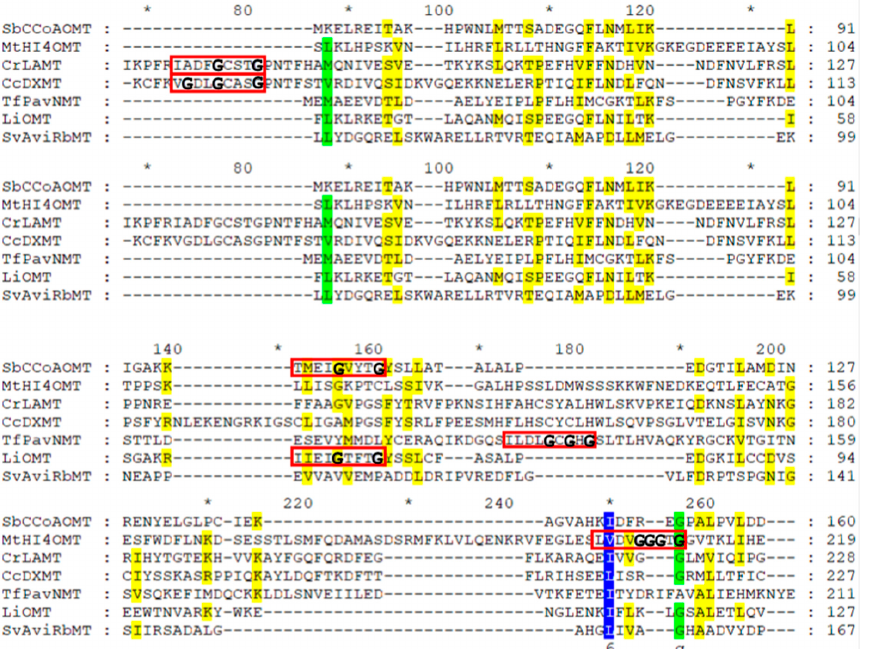
Figure 3. Alignment of the protein sequences of plant NPMTs and bacterial MTs. The plant species and accession numbers of these MTs are listed in Table 1. Plant NPMTs include cation-dependent SbCCoAOMT, cation-independent MtHI4 ′ OMT, SABATH CrLAMT, and CcDXMT, and BIA TfPavNMT, in comparison to the bacterial MT within Class I bacterial LiOMT ( Leptospira interrogans , WP_000087781), and non-Class I bacterial SvAviRbMT ( Streptomyces viridochromogenes , WP_003998250). The red boxes indicate the glycine-rich Rossmann fold consensus sequences with 0–3 mismatches. The amino acid residues highlighted in blue are highly conserved, those in green are conserved, and those in yellow are moderately conserved. “*” represents every 10 th amino acid after each numerical indicator.